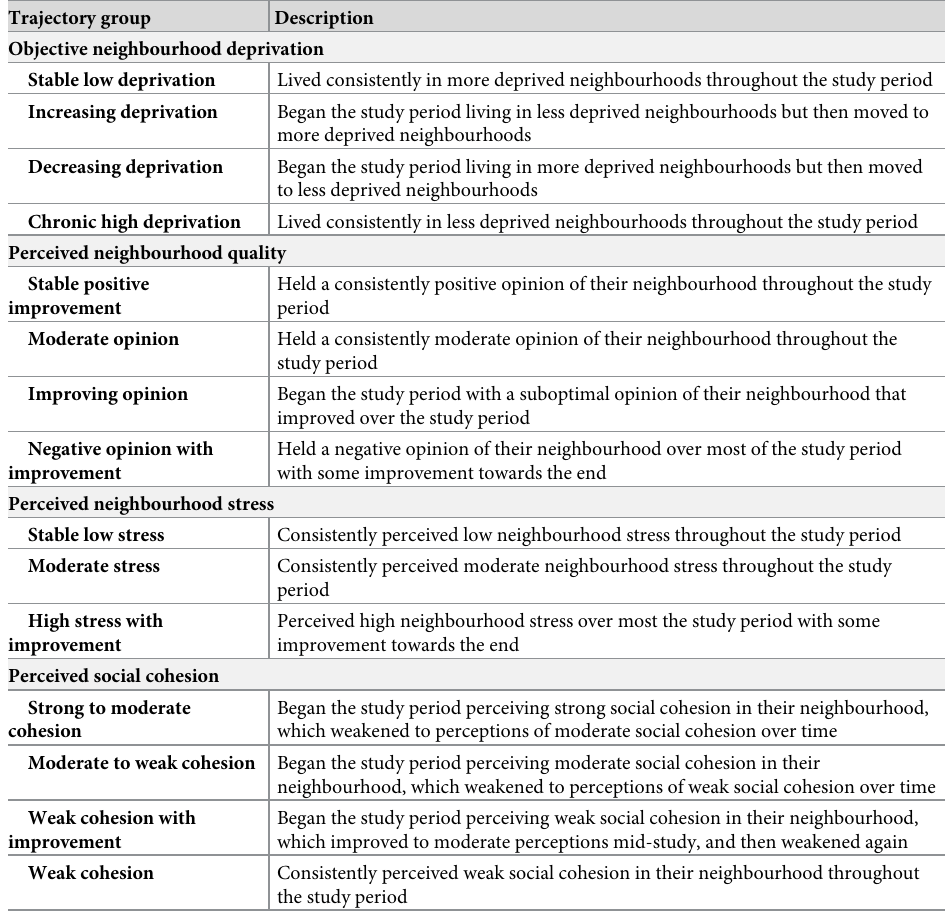
Table 4. Description of estimated trajectory groups by neighbourhood